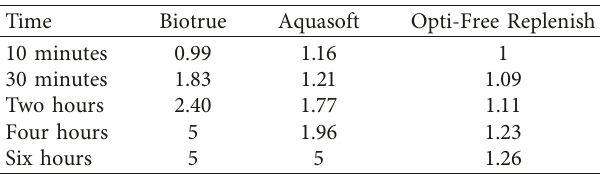
Table 4: Log reduction per solution per time interval for Pseu- domonas